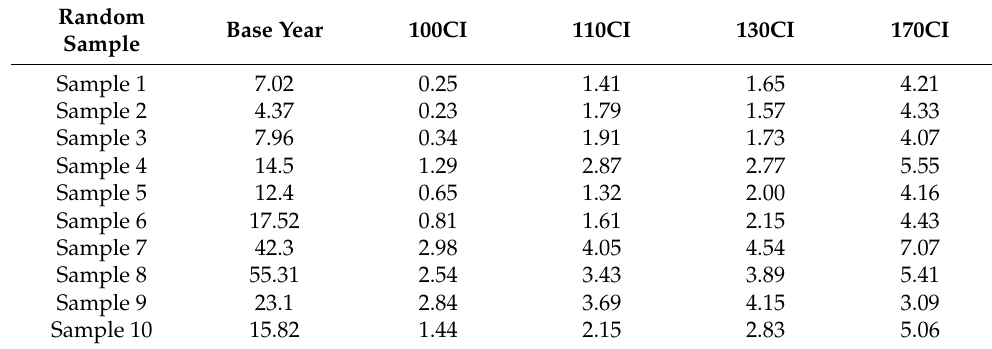
Table 6. Fluctuations of groundwater levels compared with base